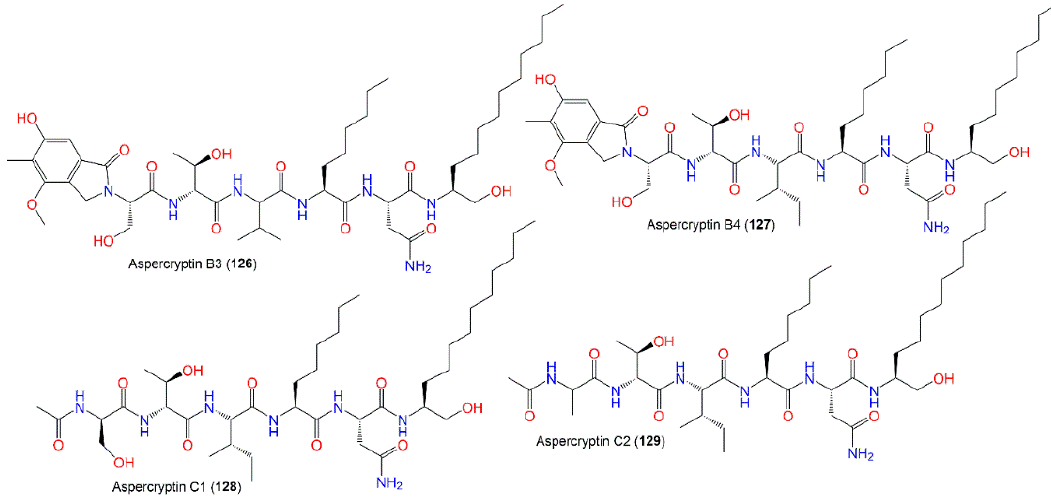
Figure 13. Structures of peptides ( 126 – 129 ).